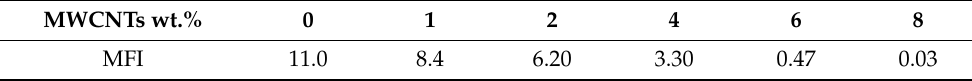
Table 4. Effect of MWCNTs on melt flow index (MFI) of polypropylene. MWCNTs wt.%